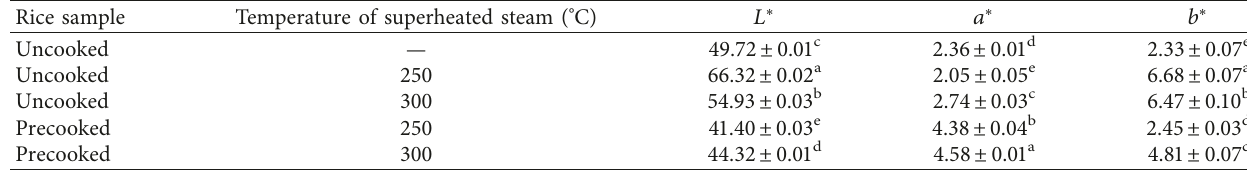
Table 3: Color of black glutinous rice with/without superheated steam treatment.